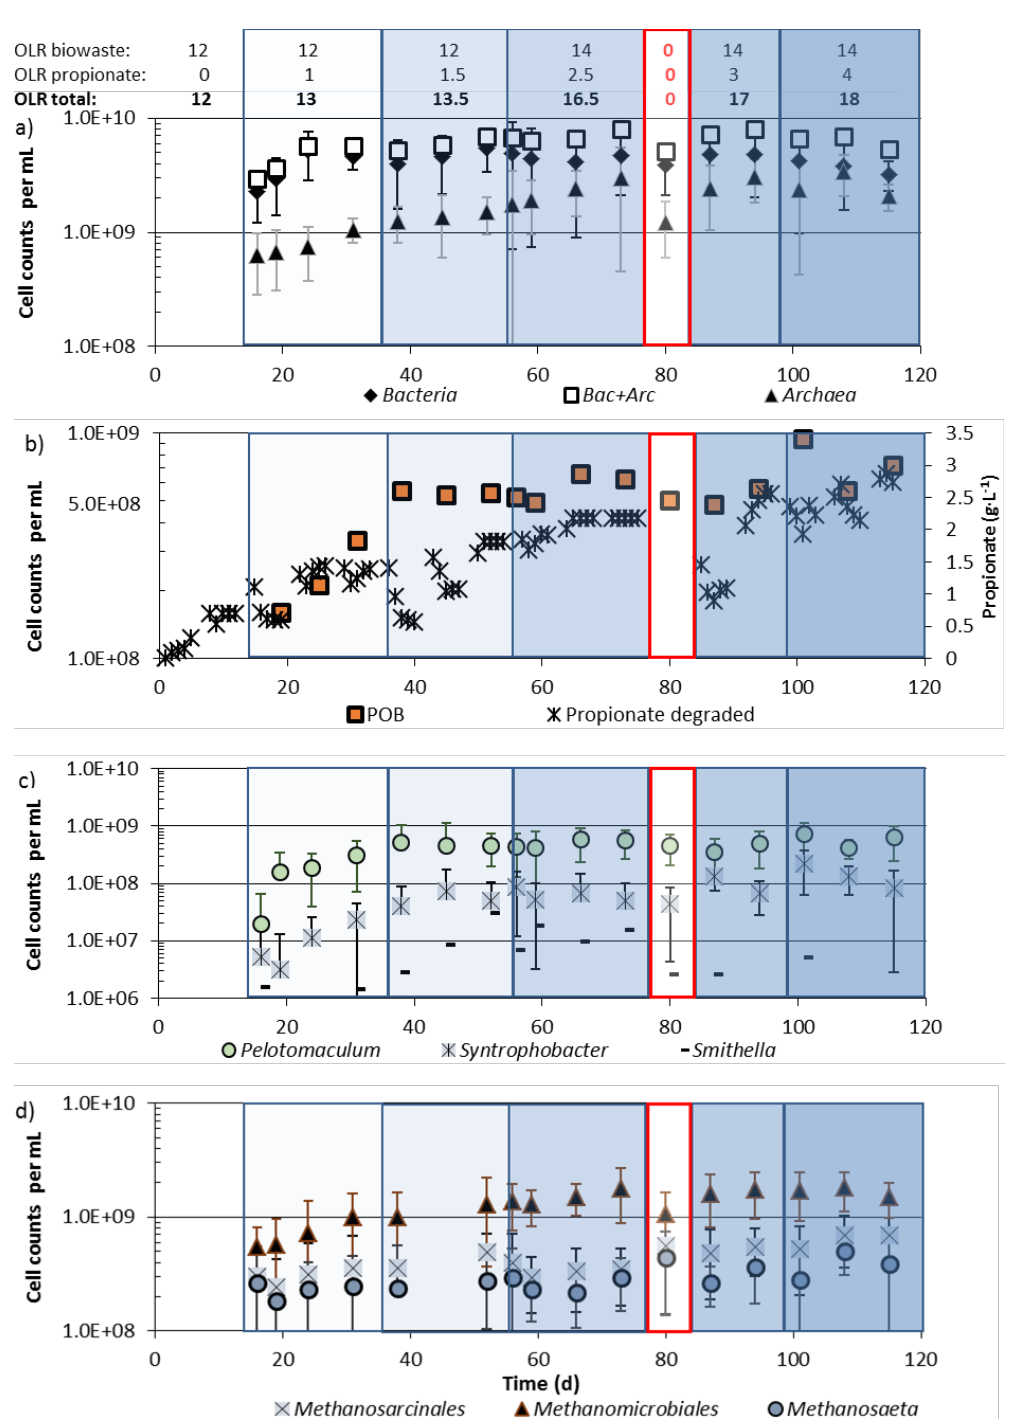
Figure 6. Total Bacteria and Archaea ( a ), propionate-oxidizing bacteria (POB; b , c ), and methanogenic archaea ( d ) in reactor 2, during feeding of biowaste at an OLR of 12 (day 1–55) or 14 (day 55 onwards) kg COD biowaste ·m −3 ·d −1 and propionate up to 4 kg COD propionate ·m −3 ·d −1 . For sample preparation see Section